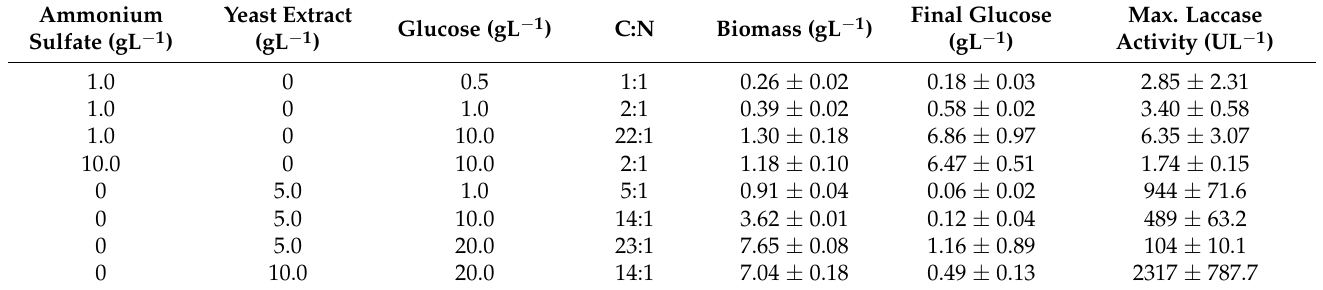
Table 2. Biological growth parameters of Pleurotus ostreatus in culture media with ammonium sulfate or yeast extract in submerged